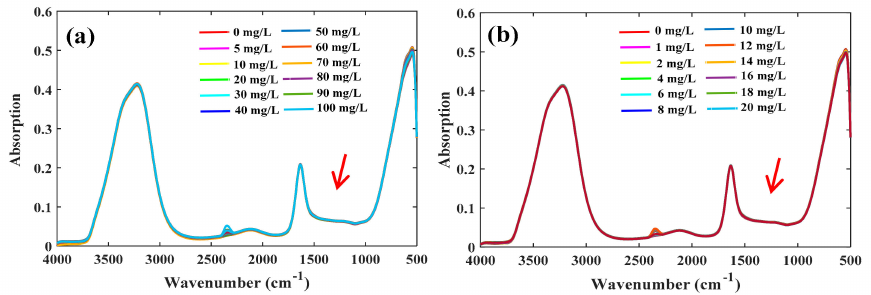
Figure 1. Fourier transforms mid-infrared attenuated total reflectance (FTIR-ATR) spectra of nitrate solutions. ( a ) High-concentration group; ( b ) low-concentration group.